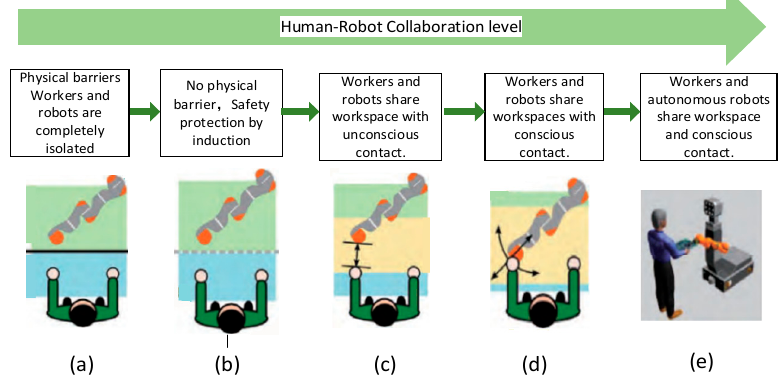
Figure 1. Development of human–robot cooperation.